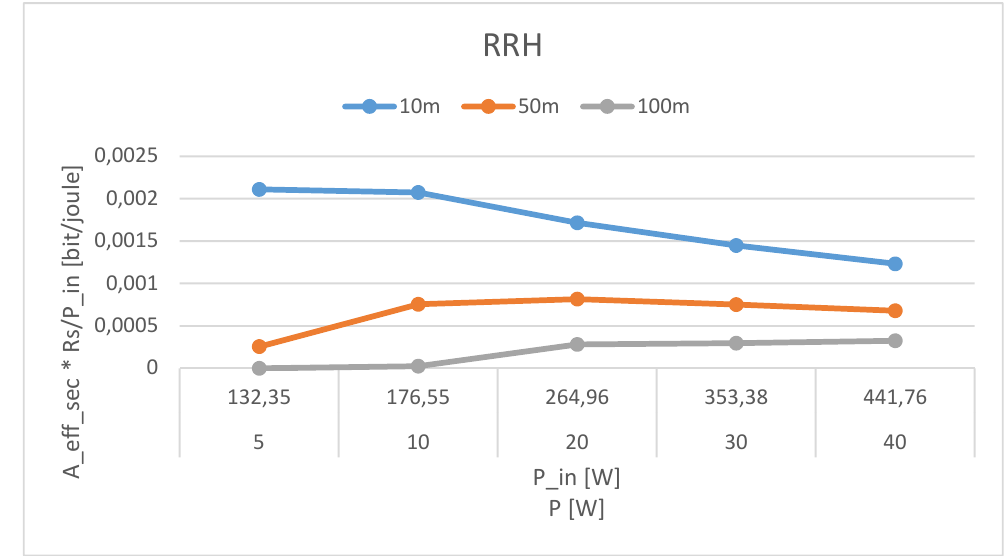
Figure 6. Effective Secrecy-Energy Efficiency as a function of the power consumption P in for different distances of the legitimate receiver { 10,50,100 } m. The corresponding radiated power P is reported in the x -axis under the P in value. The power consumption is referred to a Remote Radio Head (RRH).